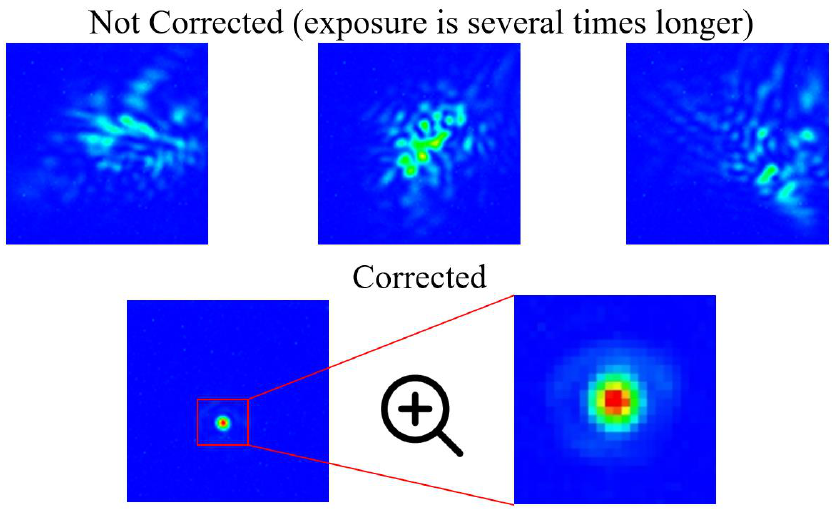
Figure 7. Far-field images. Top row — without correction; bottom row — during correction.